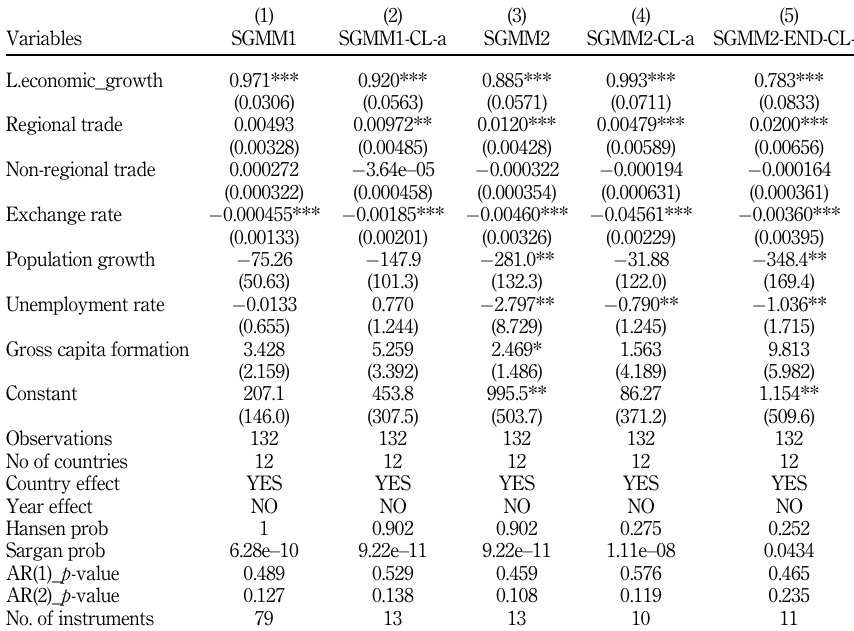
Table IV. Dynamic panel data analyses – system